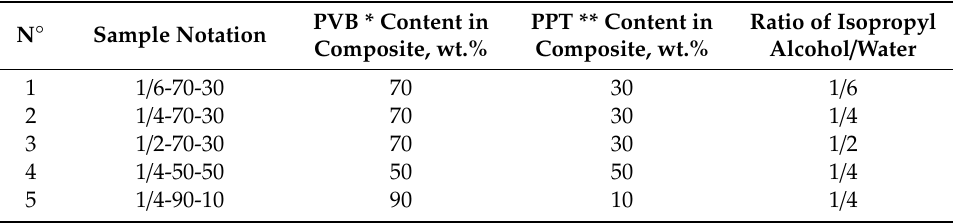
Table 1. The compositions of porous composite materials based on potassium polytitanate. PVB * Content in PPT ** Content in Ratio of N ◦ Sample Notation Composite, wt.% Composite, wt.%